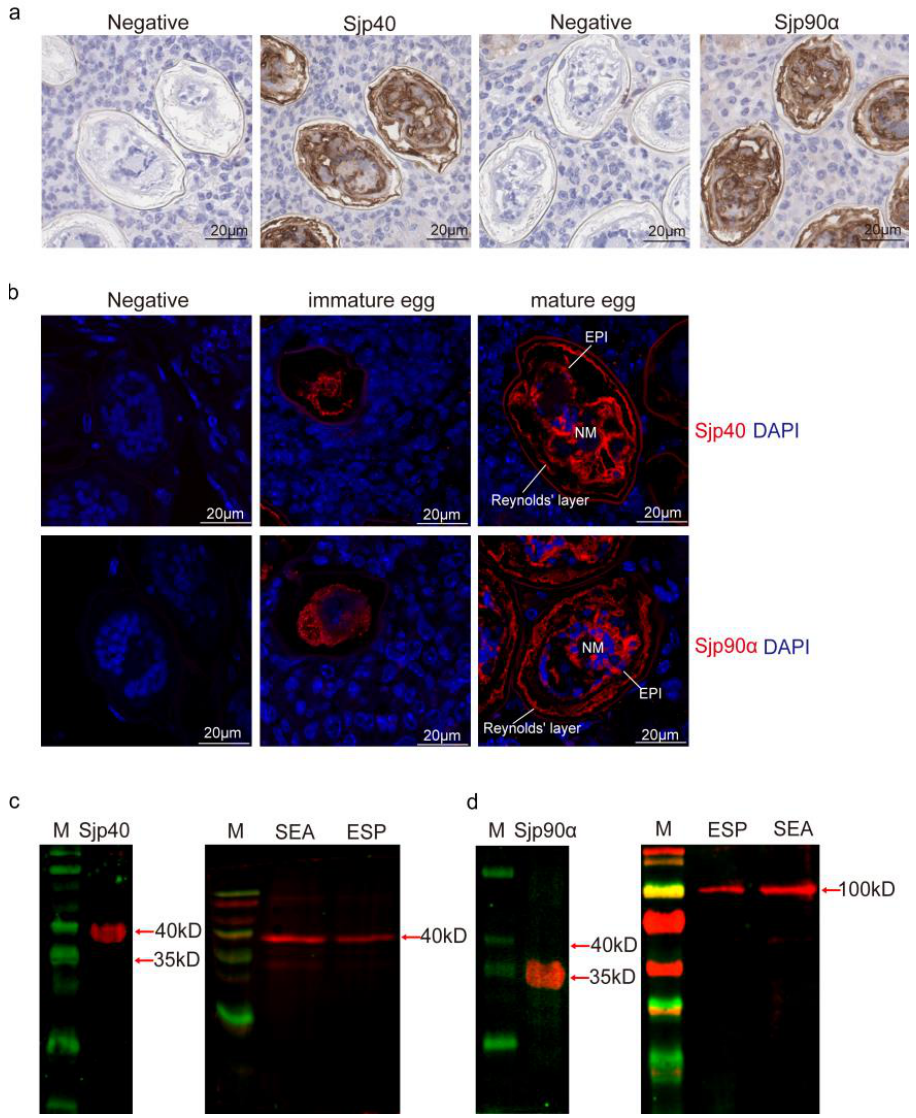
Figure 3. Native Sjp40 and Sjp90α identified in eggs and egg secreted proteins (ESP) of S. japonicum. Immunolocalization of Sjp40 and Sjp90α in eggs trapped in infected mouse liver probed with mouse anti-rSjp40 and anti-rSjp90 antibodies, respectively. Sections of livers from mice infected with S. japonicum were incubated with naïve control mouse serum (negative control) and mouse anti-rSjp40 or anti-rSjp90α antiserum, and subsequently with horseradish peroxidase (HRP)-conjugated secondary antibody ( a ) or Alexa-Fluor 647-conjugated secondary antibody ( b ). DAPI stained nuclei are blue. A section of schistosome eggs in a developing granuloma shows SjP40 or Sjp90 staining (brown in HRP labelling and red in Alexa-Fluor 647) in eggs. NM—neural mass; EPI—epidermal cells. Scale-bars: 20 μm. ( c , d ) Western blotting was used to detect recombinant Sjp40 ( c , left lane) and Sjp90α ( d , left lane). Anti-rSjp40 ( c , right lane) and anti-rSjp90 ( d , right lane) were used to probe protein extracts of the soluble egg antigen (SEA) and egg secreted protein (ESP).